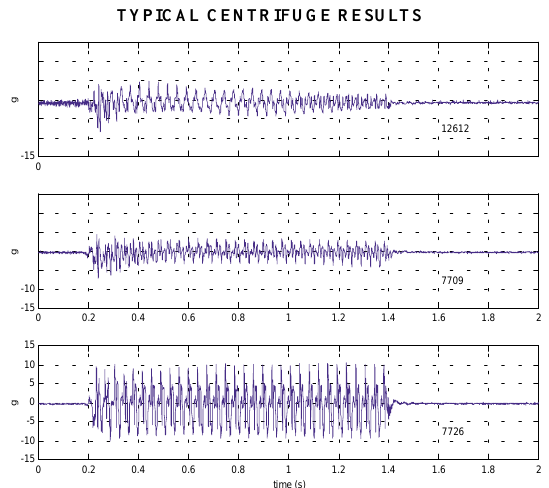
Fig. 4. Recorded accelerations (units of g) in the test model: mea- sured in dense sand near the top of the container, in dense sand at the middle and at the bottom of the container in an underlying looser sand